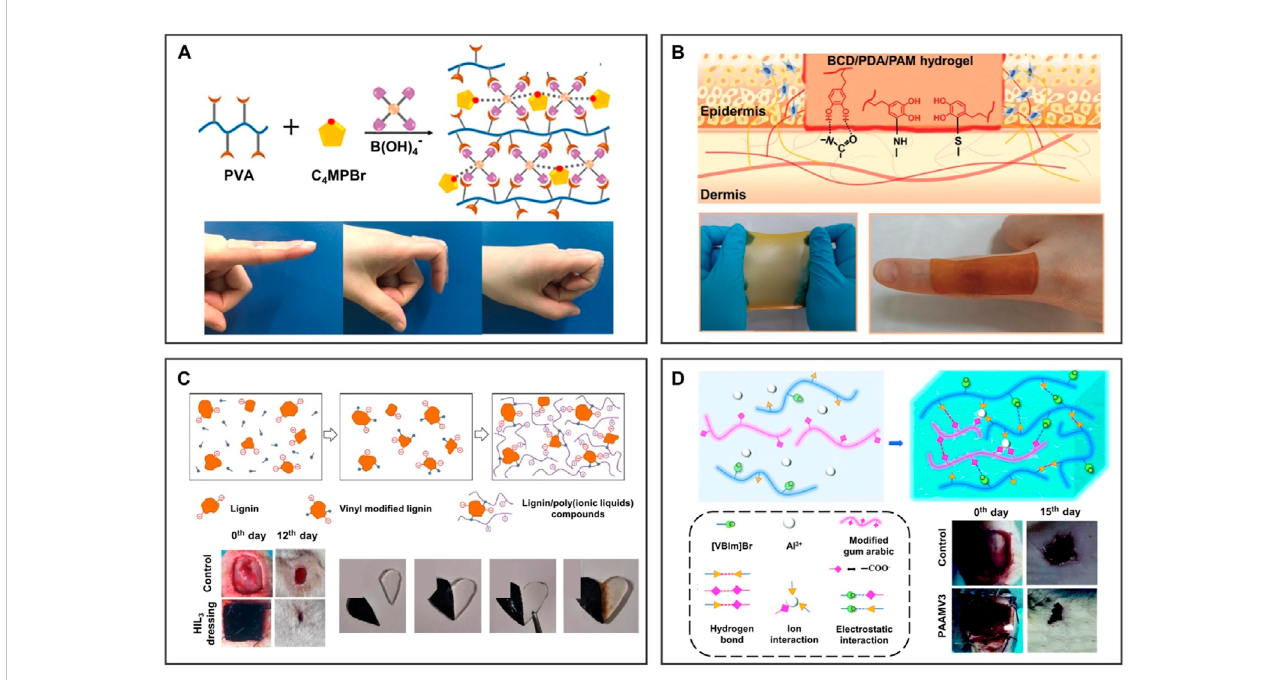
FIGURE 11 BILIMsforwounddressing. (A) Incorporationofpyrrolidinetoprovideionogeladhesionforapplication inwounddressings.Reproducedwithpermission (Yu et al., 2020). Copyright 2020, Elsevier B.V. (B) After the introduction of PDA containing abundant catechol groups, ionogel can be attached to the areas where the body moves greatly and realize the treatment of special regional wounds. Reproduced with permission (Yang et al., 2021). Copyright 2021, Wiley- VCH GmbH. (C) Lignin with a three-dimensional network structure and antioxidant activity was introduced into ionogel, which showed good antibacterial activity and promoted wound healing. Reproduced with permission (Zhang X. et al., 2020). Copyright 2020, Elsevier B.V. (D) After combining ILs with hydrogel dressing containing migratable ions, dressing promotes the migration of ions, thus promoting self-healing performance. Reproduced with permission (Li et al., 2021). Copyright 2021, The Royal Society of